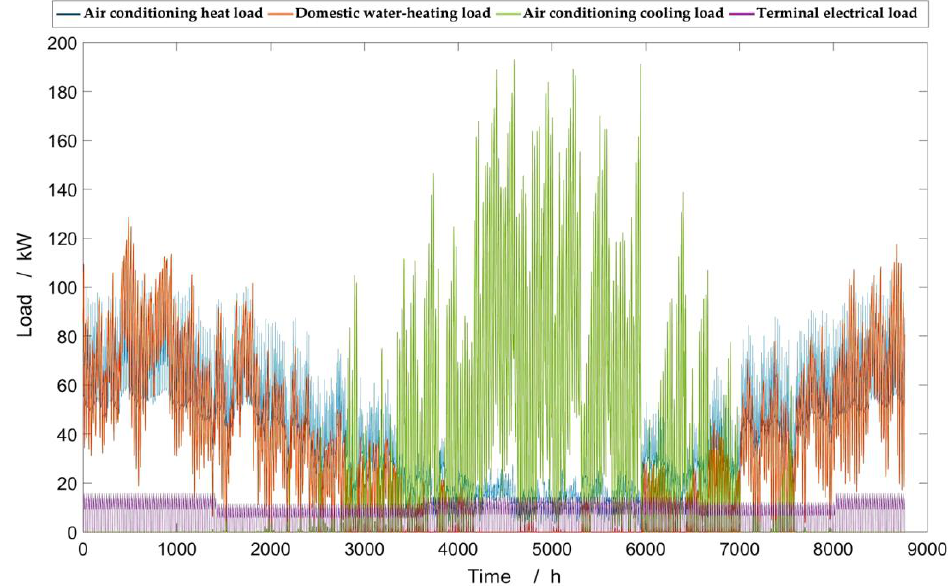
Figure 6. Annual hourly terminal load.